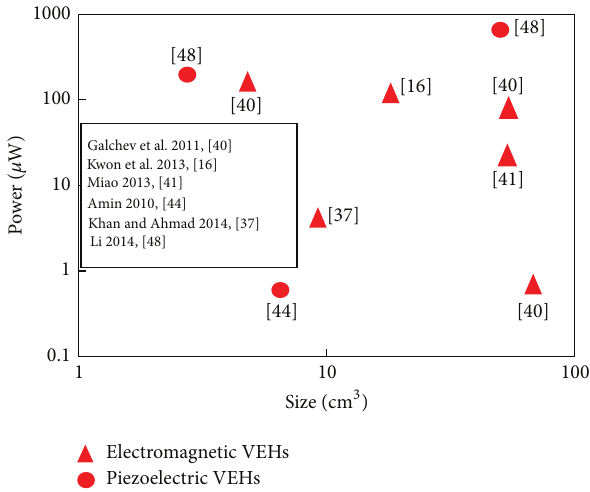
Figure 22: Power density versus resistance of different bridge vibration energy harvesters.